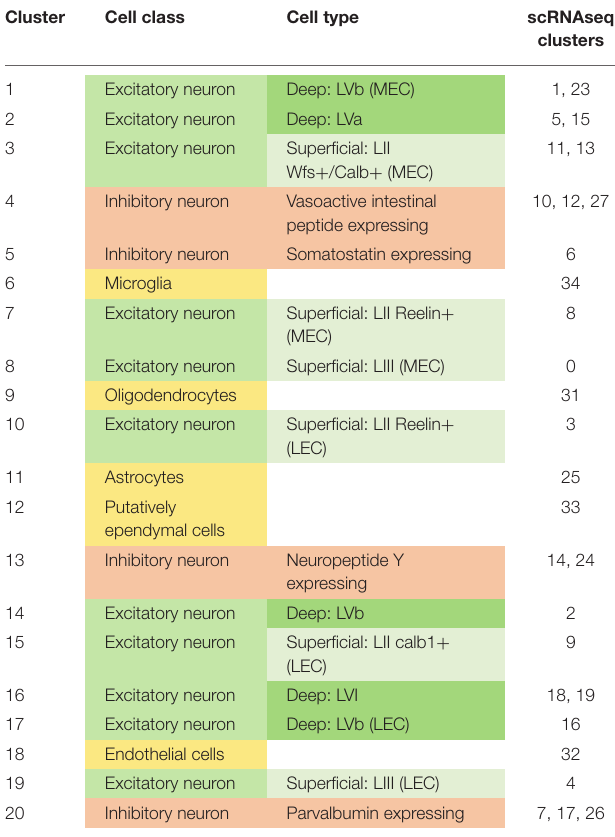
( Figure 5A ; Supplementary Figure 7 ; Supplementary Table 5 ; Table 2 ). Of the 36 clusters, 30 could be identified as neuronal cell types. After hierarchical clustering on averaged gene expression (per cluster), several small non-neuronal clusters (30, 32, 33) were classified in unexpected clades. This is likely not due to mitochondrial genes ( Figure 5 ; Supplementary Figure 8 ). Of the neuronal cell types, 11 have transcriptional profiles of different types of inhibitory neurons, while the rest have profiles